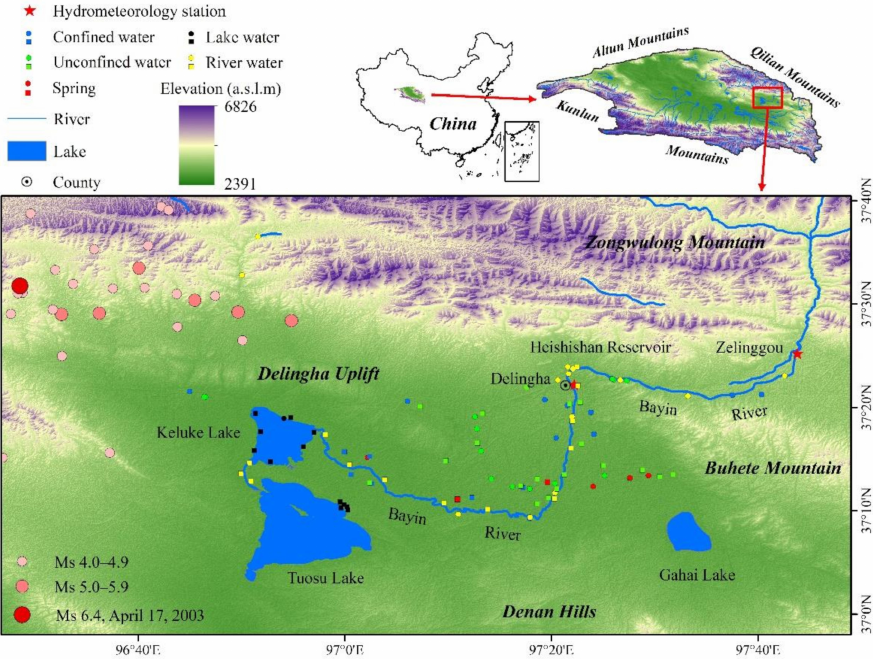
Figure 1. Spatial map representing the distribution of samples, including river, lake, spring, confined groundwater, and phreatic groundwater in the northeast of the Qaidam Basin, China. Squares represent samples from the literature